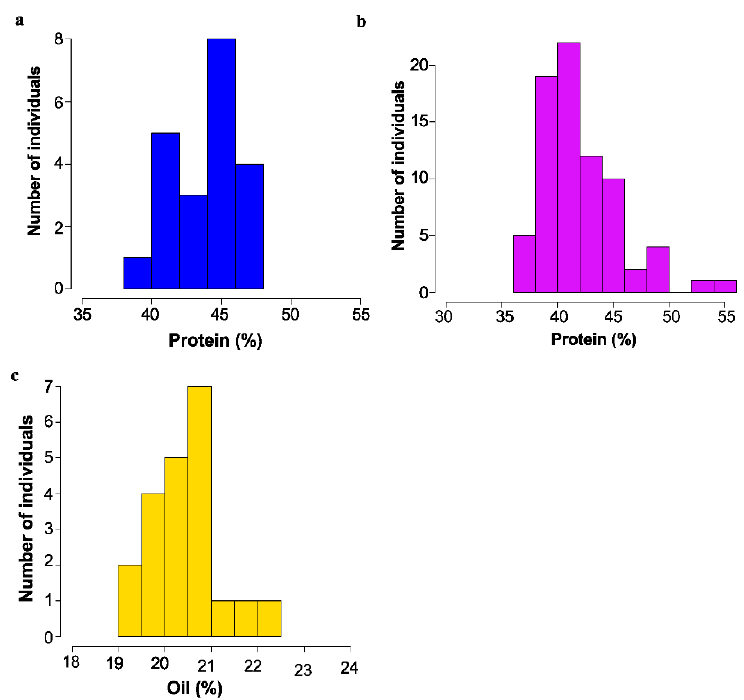
Figure 3. Mature seed protein or Oil content as determined by NIR as % dry weight basis. for mutant backcross populations. ( a ) Segregation of protein content in 16475 × Williams-82 F 3 ; bulk seed samples. ( b ) Segregation of protein content in 18734 × Williams 82 F 3 bulk seed samples. ( c ) Segregation of oil content in 17238 × Williams 82 F 3 bulk seed samples.